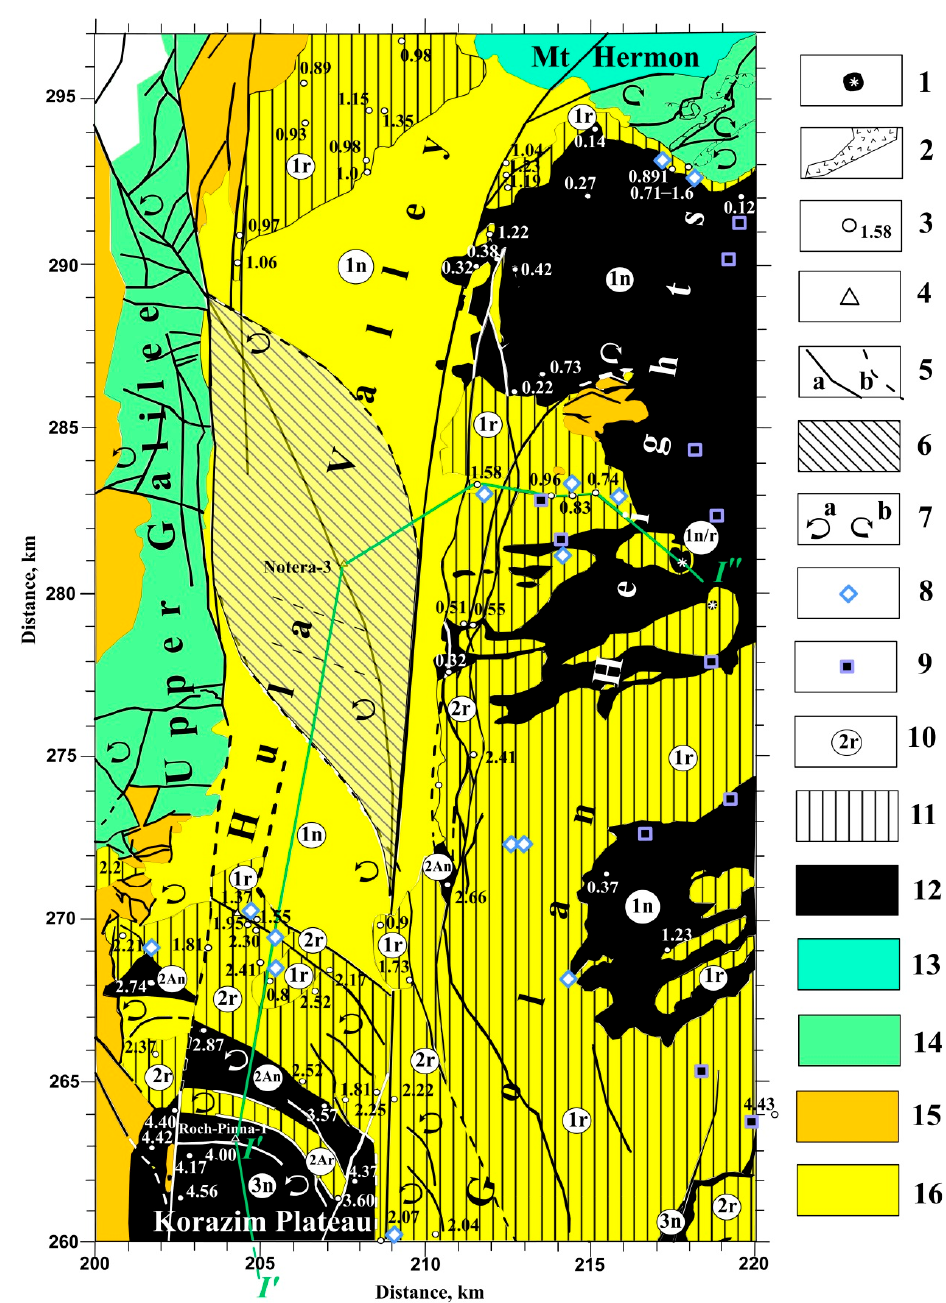
Figure 6. Paleomagnetic-geodynamic map of the Hula Basin and adjacent areas of the Golan Plateau, Hermon Mt., and Galilea uplift, HU (see its location in Figure 1). (1) volcanic cones, (2) Cretaceous traps, (3) outcrops with the radiometric ages of basalts (in Ma), (4) boreholes, (5) faults: (a) observed, (b) reconstructed, (6) pull-apart basin, (7) tectonic blocks rotations: (a) counterclockwise, (b) clockwise, (8) outcrops with the determined reversely magnetized basalts, (9) outcrops with the determined normally magnetized basalts, (10) chrons of Geomagnetic Polarity Timescale, (11) areas of the reversely magnetized basalts, (12) areas of the normally magnetized basalts, (13) Gissar superzone, (14) Jalal superzone, (15) Tuarkyr—Khorezm superzone, (16) Sogdiana superzone. Tectonic setting after: [76,97,104–106]. Radiometric data (K-Ar and Ar-Ar) after: [73,74,78,90,97,107]. Paleomagnetic data: [74,75,85,95,97,101]. The bold green line designates the location of paleomagnetic profile I (cid:48) – I (cid:48)(cid:48)